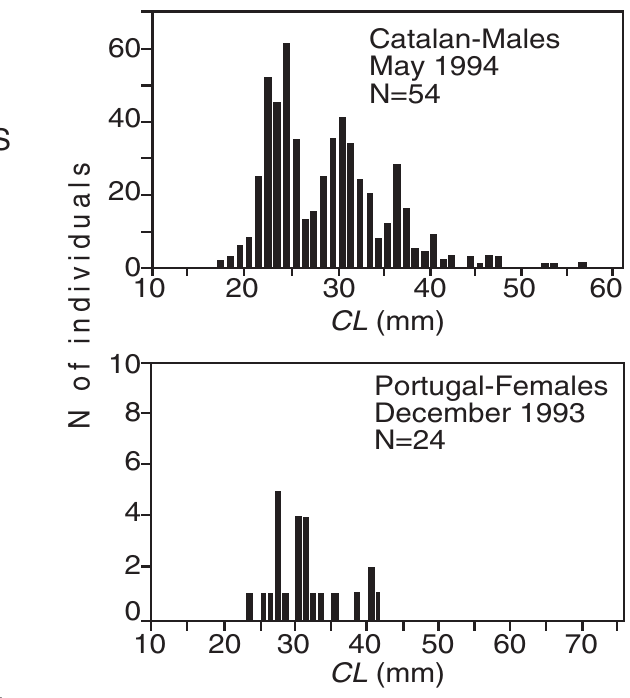
F IG . 2. – Examples of a “good (Catalan-males) and a “poor” (Portugal-females) length frequency distribution. In the first distri- bution the modes are clearly observed in contrast to the second one. CL , carapace